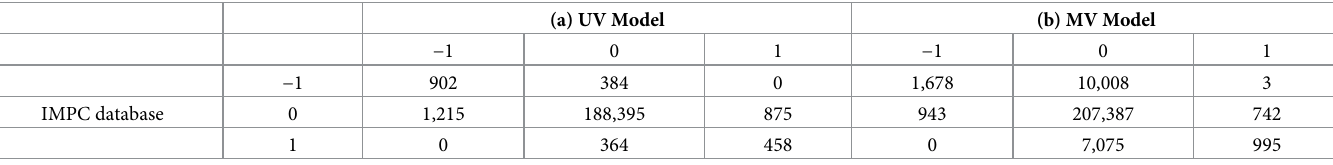
Table 1. Comparison of signed hits with the existing IMPC database. (a) UV model; and (b) MV model. Each model is compared to the corresponding hits called in the existing IMPC database (top). We represent calls by a number in { − 1,0,1}, with 1 and − 1 denoting significant positive and negative phenotypic perturbations, respec- tively, and 0 denoting a lack of statistical